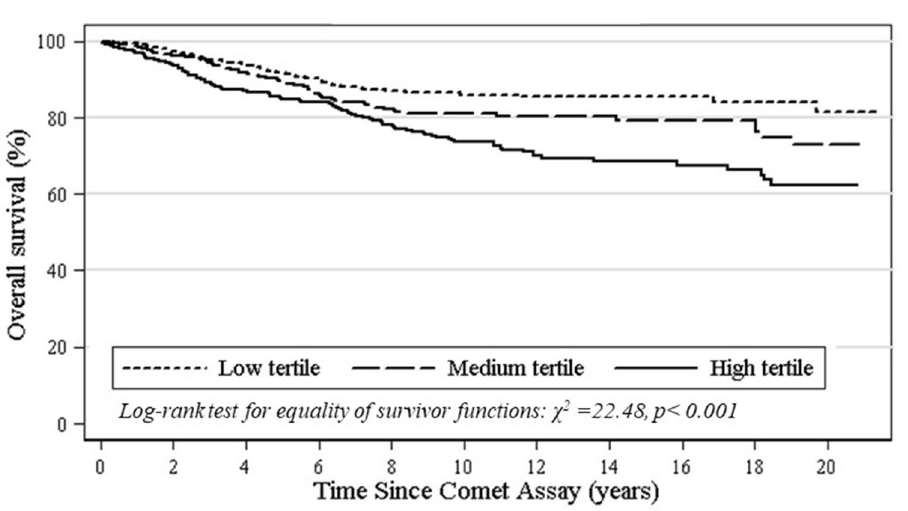
Figure 2. Kaplan–Meier curve for overall mortality by tertile of DNA damage (%T) measured by the Comet assay. The hCOMET